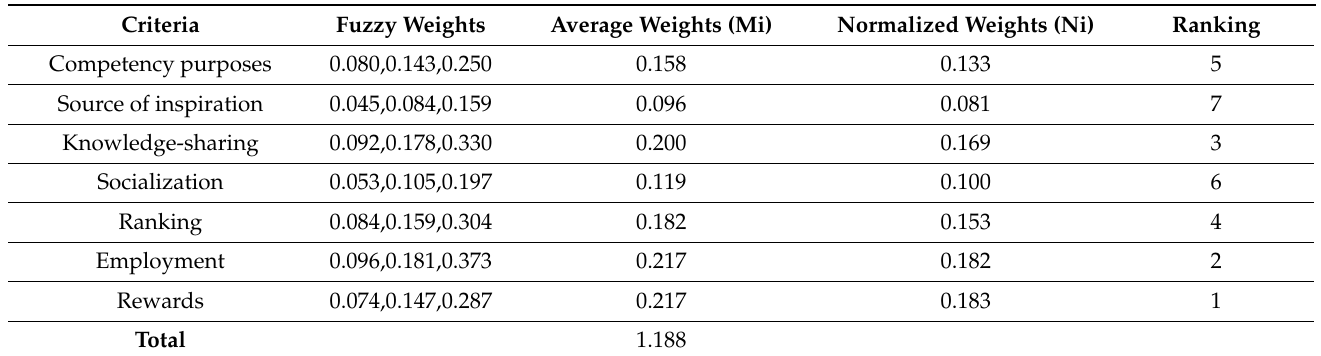
Table 5. Fuzzy weights along with normalized weights of criteria.